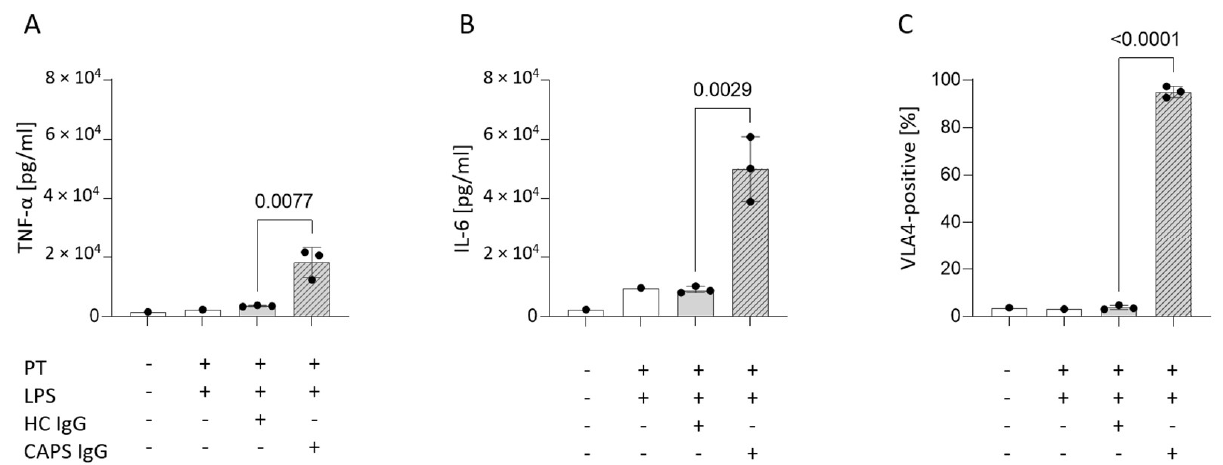
Figure 4. Mimicking catastrophic APS in vitro. Levels of soluble TNF-α ( A ) and IL-6 ( B ) in cell culture supernatants and VLA4 ( C ) surface expression after stimulation with CAPS IgG or HC IgG for 16 h. Untreated cells were completely naive while PT was added to all other stimulations since the CAPS IgG also contained high levels of aPS/PT antibodies. LPS and PT alone had minimal effect therefore combination of both was used as a background. The bars represent mean ± SD in three technical replicates. Statistical differences between CAPS and HC IgG stimulations were assessed by student’s t-test ( p < 0.05). APS, antiphospholipid syndrome; CAPS, catastrophic APS; HC, healthy